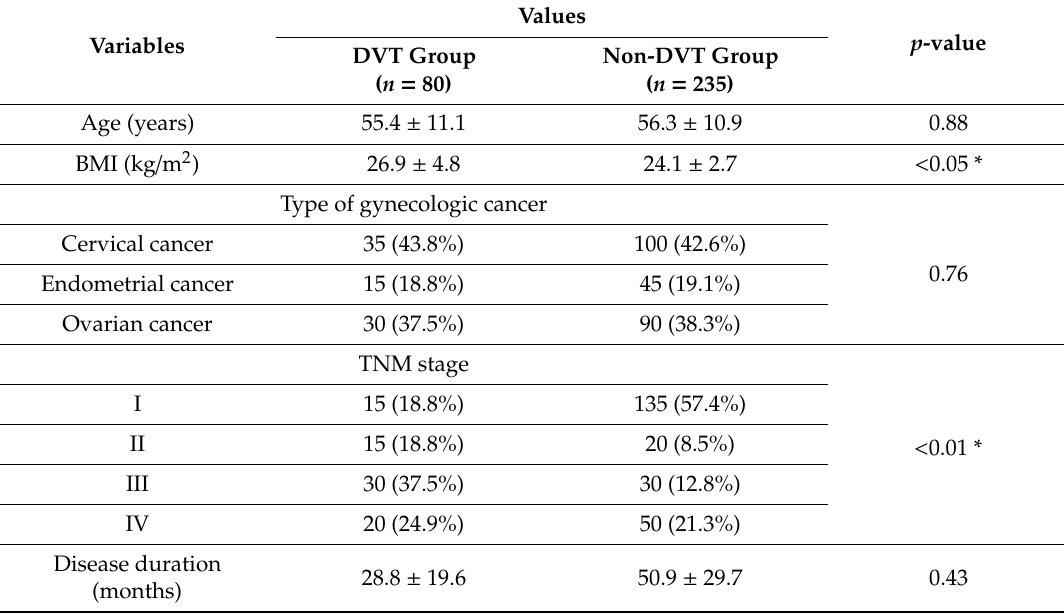
Table 2. Patient characteristics in each